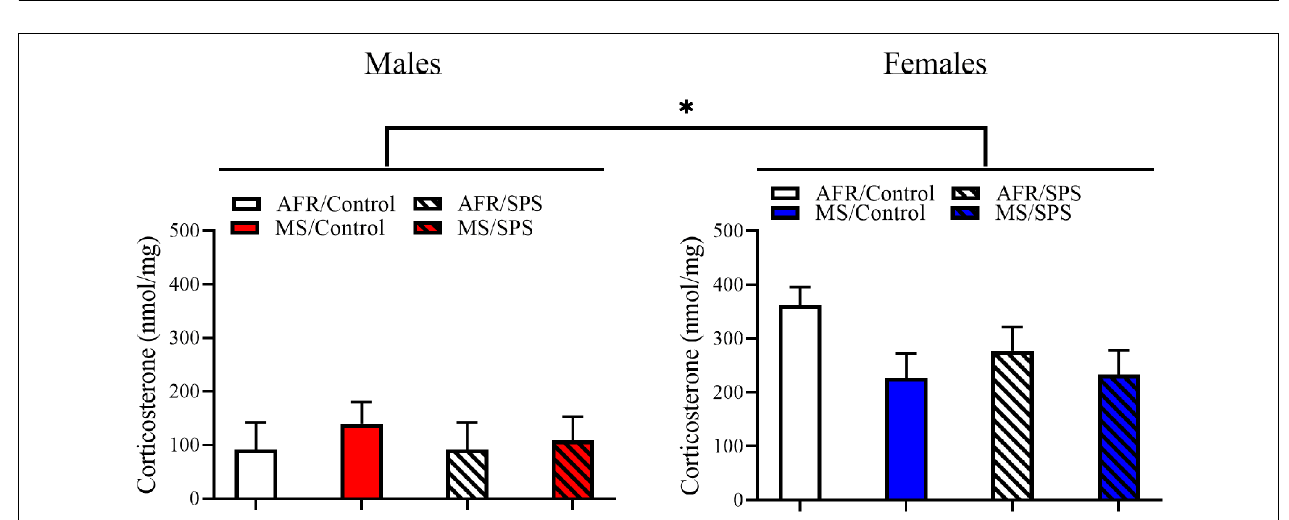
FIGURE 3 | The effects of MS and SPS on basal corticosterone levels. Female rats (AFR/control = 18, AFR/SPS = 10, MS/control = 10, MS/SPS = 10) had higher levels of corticosterone than males (AFR/control = 18, AFR/SPS = 8, MS/control = 12, MS/SPS = 10), but basal corticosterone levels were not affected by MS or SPS. ∗ Significant statistical test at p <